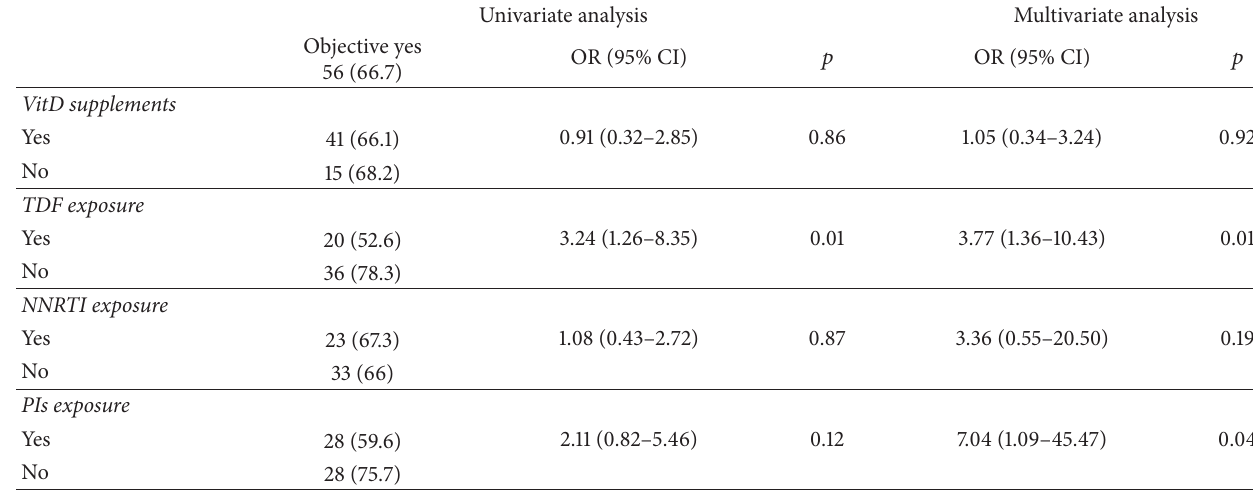
Table 4: Patients with vitamin D < 10ng/mL at baseline. Objective PTH < 65 pg/mL.